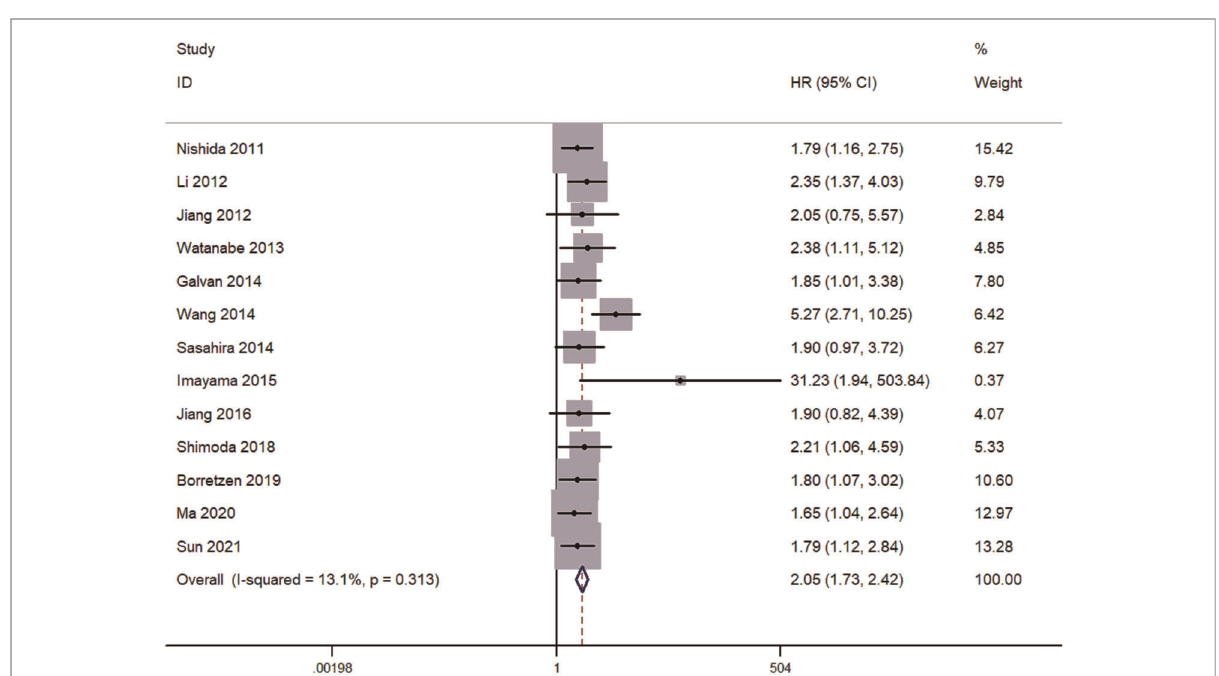
FIGURE 2 Forest plots for the relationship between high FOXC2 expression and